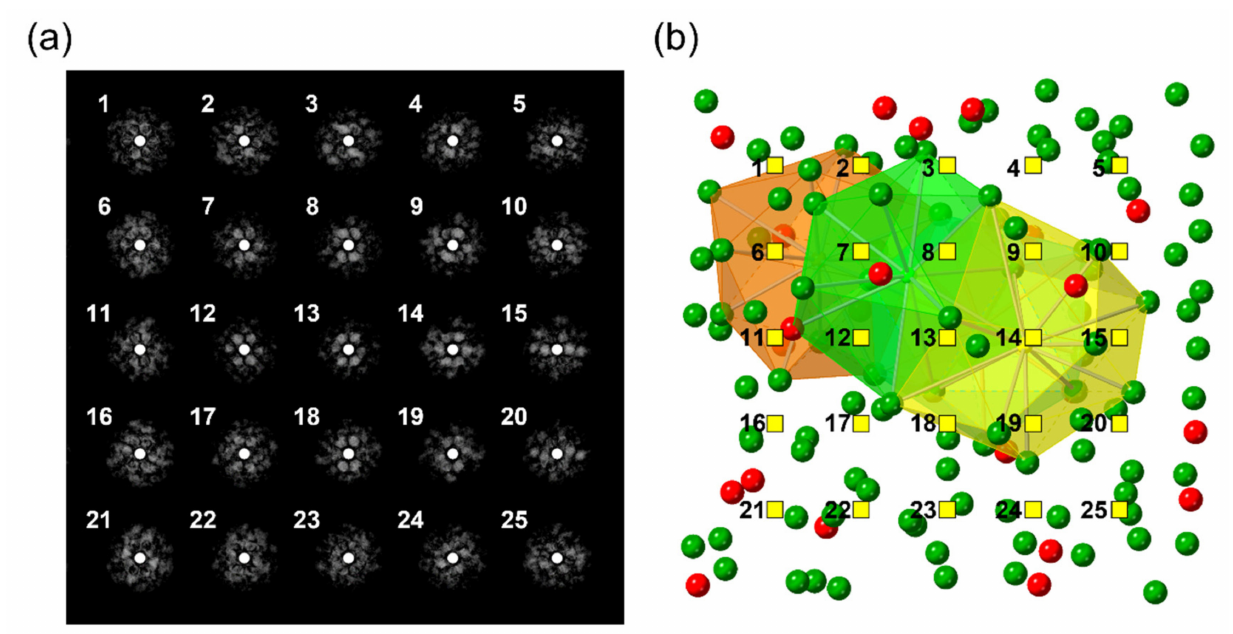
Figure 3. ( a ) Calculated electron diffraction patterns surrounded by the dotted lines in Figure 2. ( b ) Atomic configuration, including the positions (position 1–position 25) where electron diffraction patterns are calculated for each. Coordination polyhedra are also